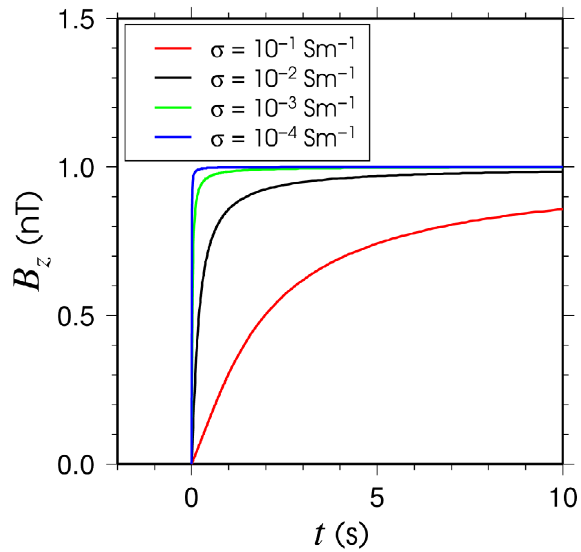
Figure 6. A comparison of the temporal variation in the horizontal component of the magnetic field for the source-receiver geometry shown in Figure 4a for a conductive whole-space (solid black line) and two-layer model (dotted line). For reference, the solution for a resistive whole-space (i.e., a vacuum) is also shown.